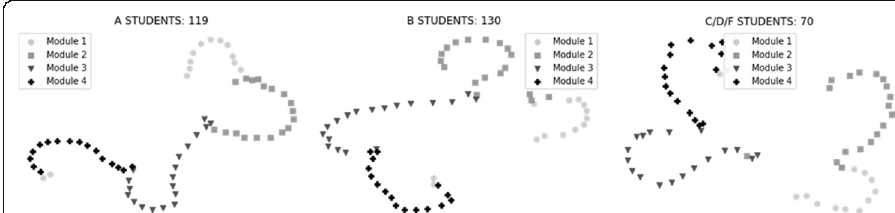
Fig. 9 Visual representations of navigational pathways of students in different grade groups. Each point represents a single course content page in the Canvas learning management system (LMS). Distances between points roughly reflect their distances in the raw clickstream sequences. Different rotations across subgraphs are only for visualization purposes. Figure based on data and analyses in Yu et al.